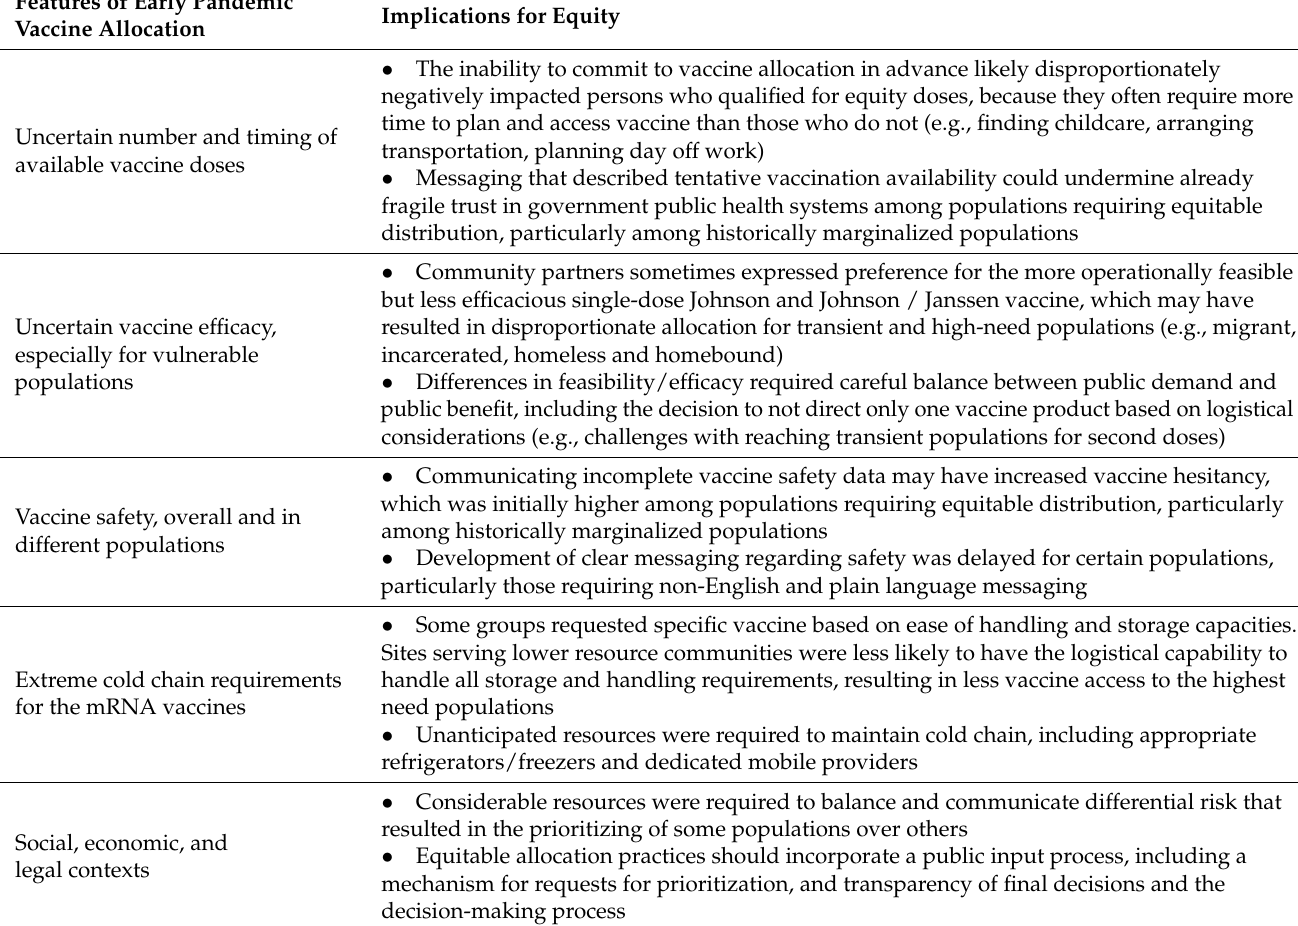
Table 3. Factors Affecting Equitable Vaccine Allocation for NH. This table, adapted from NASEM for the NH context, shows challenges associated with early pandemic COVID-19 vaccine allocation, and how these factors affected equitable vaccine allocation